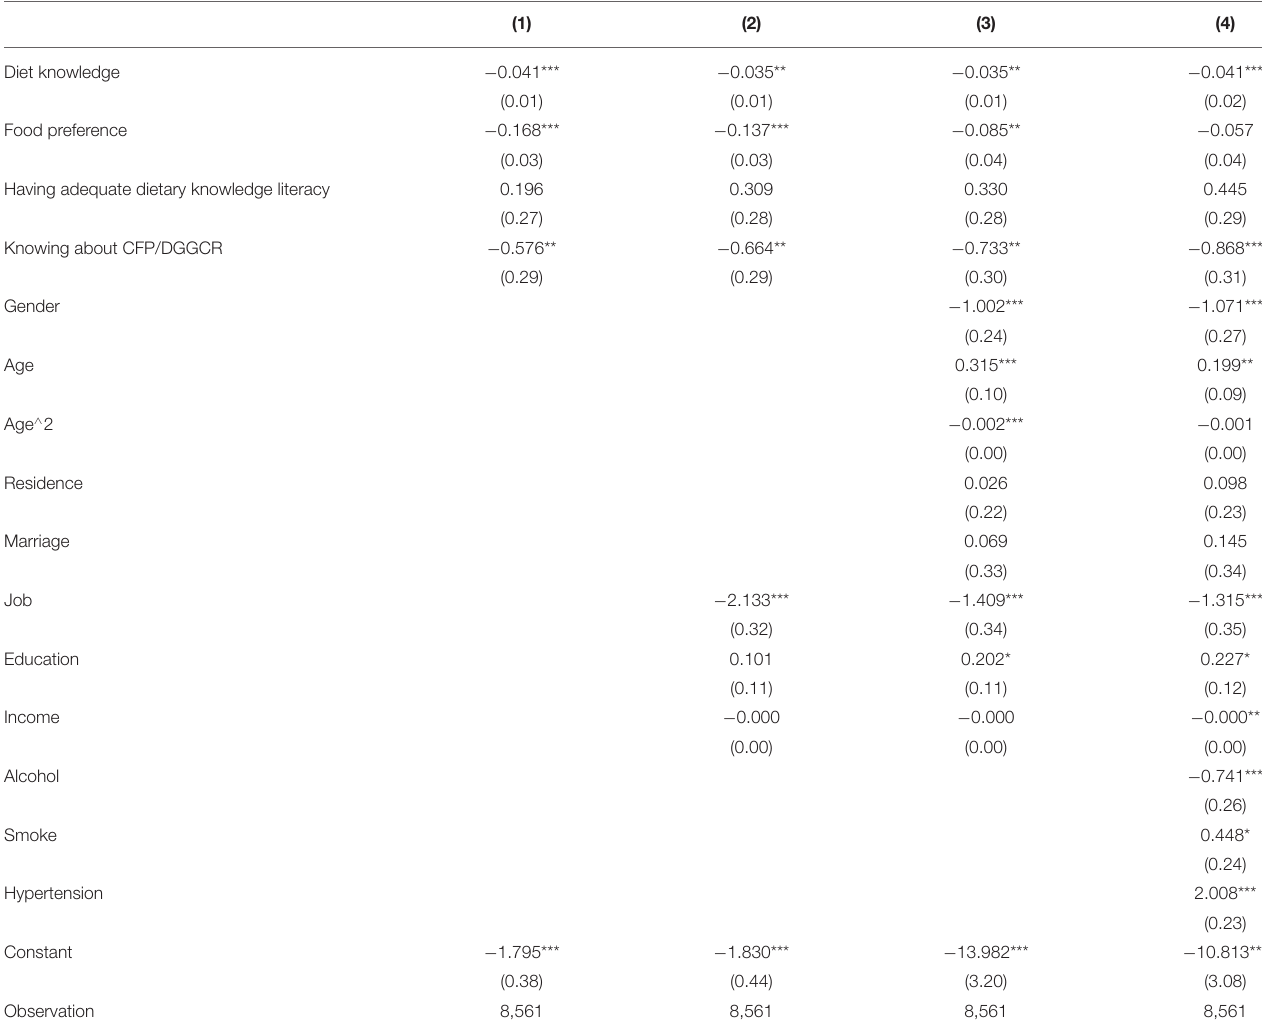
TABLE 3 | Robustness